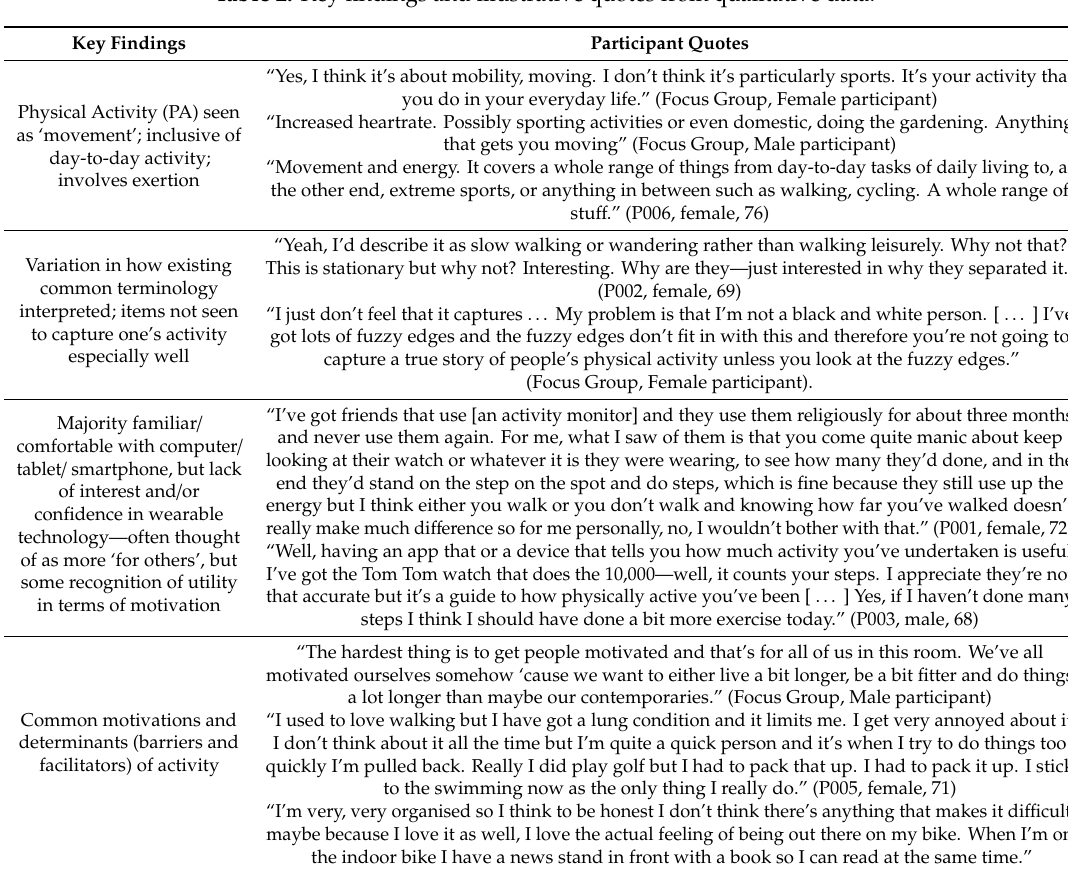
Table 2. Key findings and illustrative quotes from qualitative